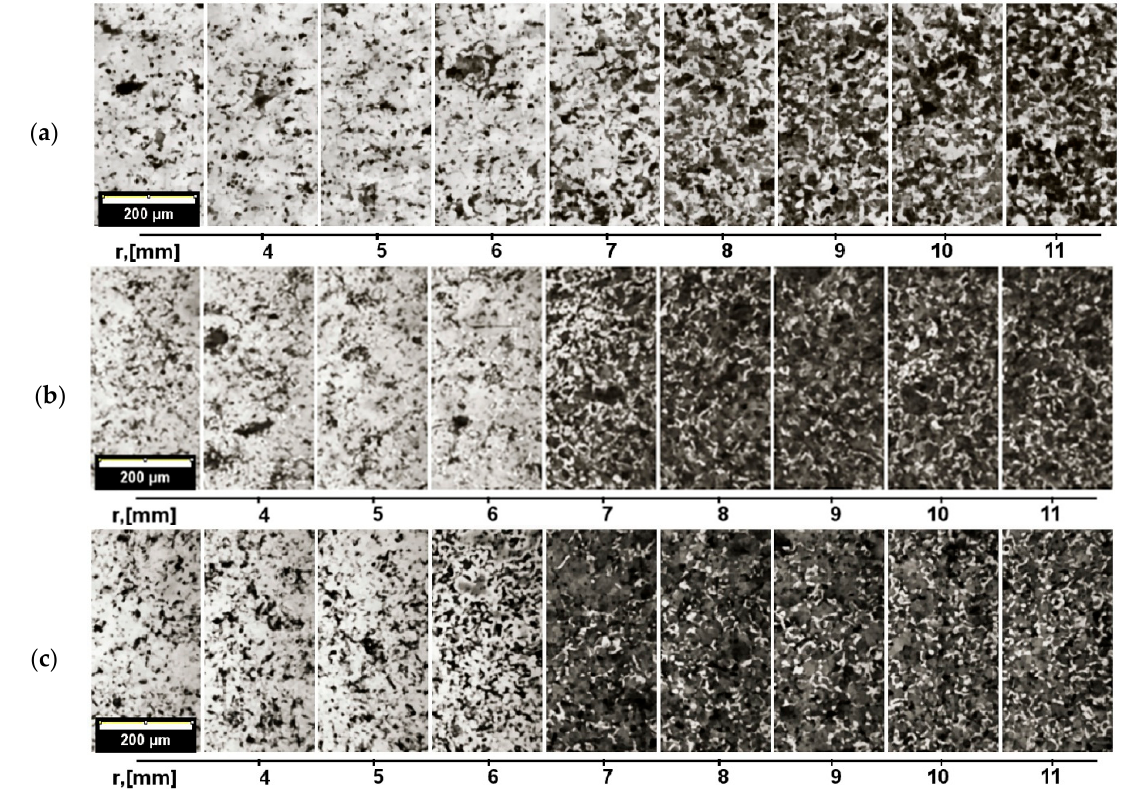
Figure 9. Volume fraction of pearlite as a function of the distance from the axis of products sintered by ( a ) conventional process: 1120 °C/30 min; ( b ) SPS: 1120 °C/1 min; ( c ) SPS: 1050 °C/10 min.